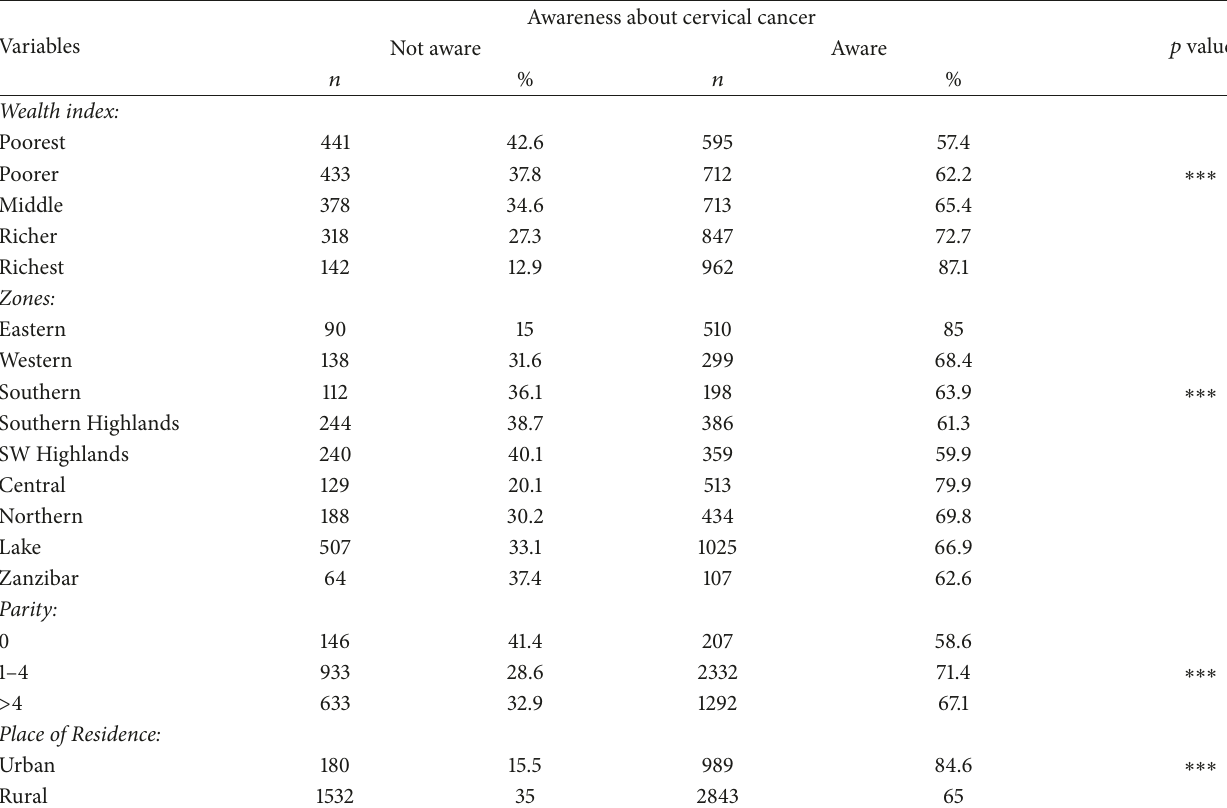
Table 2: Distribution of participants by awareness about cervical cancer and the potential factors affecting awareness (chi-square).